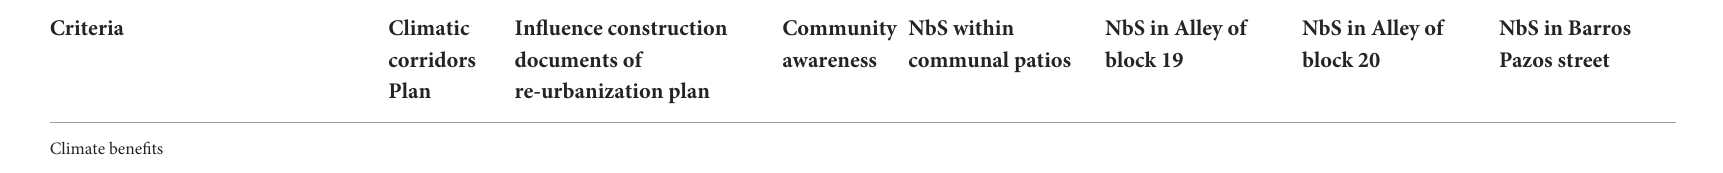
TABLE 1 Criteria used to aid prioritization of